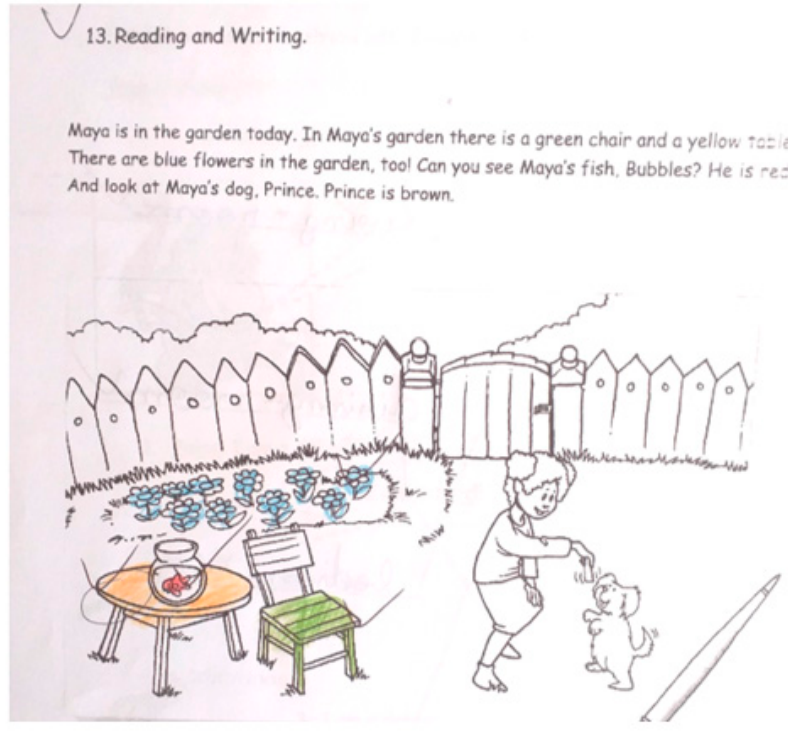
Figure 4. Understanding reading and coloring.